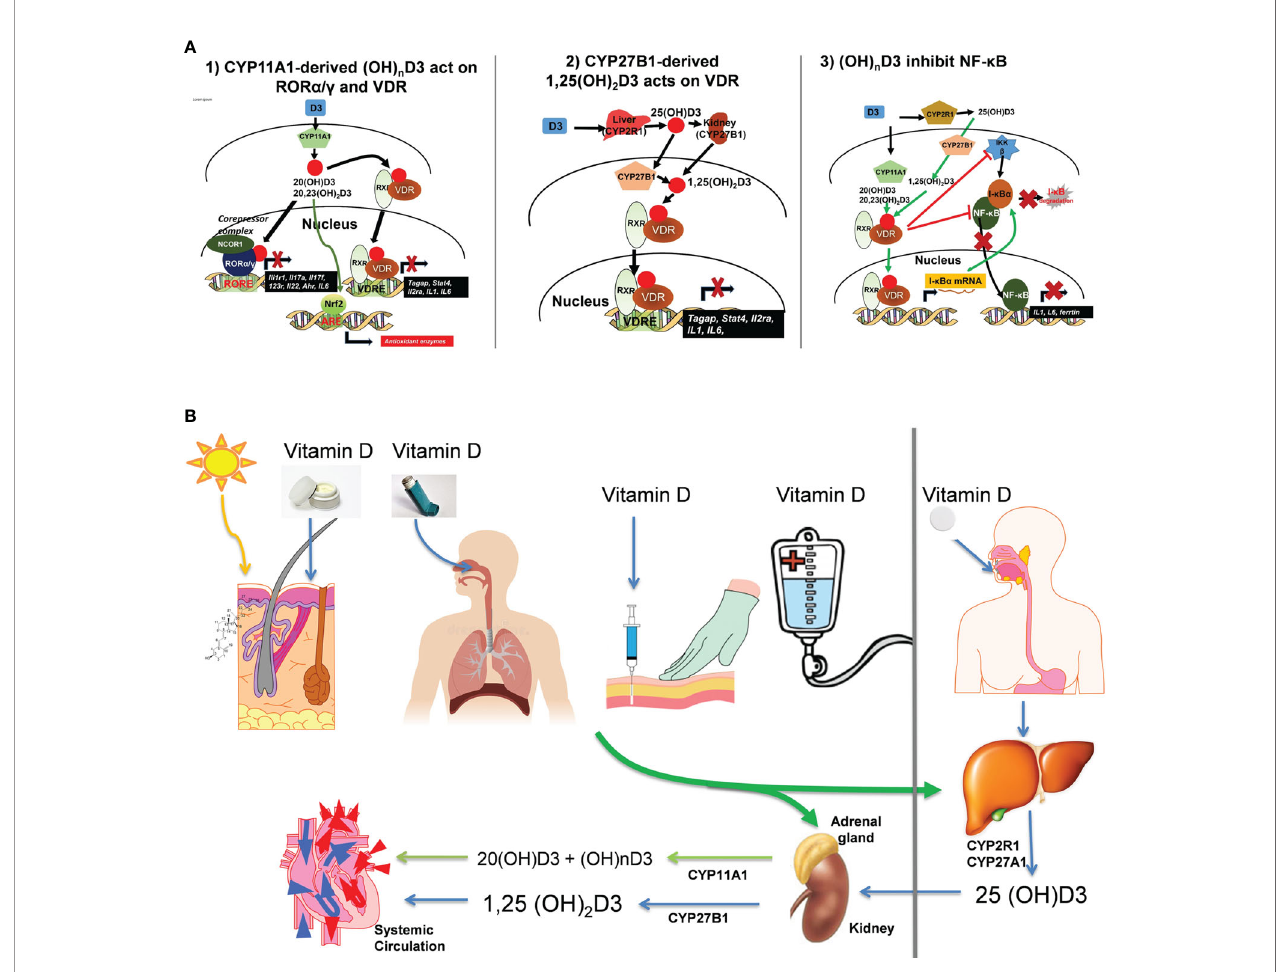
FIGURE 2 | (A) Mechanism of action of canonical and non-canonical vitamin D-hydroxyderivatives. Vitamin D signaling in mononuclear cells downregulates in fl ammatory genes and suppresses oxidative stress. VDR, vitamin D receptor; RXR, retinoid X receptor; ROR, retinoic acid orphan receptor, ROR, ROR response element; ARE, antioxidant response element; VDRE, vitamin D response element; NRF2, nuclear factor erythroid-derived 2-like 2. (B) Different routes of vitamin D delivery will impact vitamin D activation pattern. The fi gure is reprinted from (46) with a permission from the